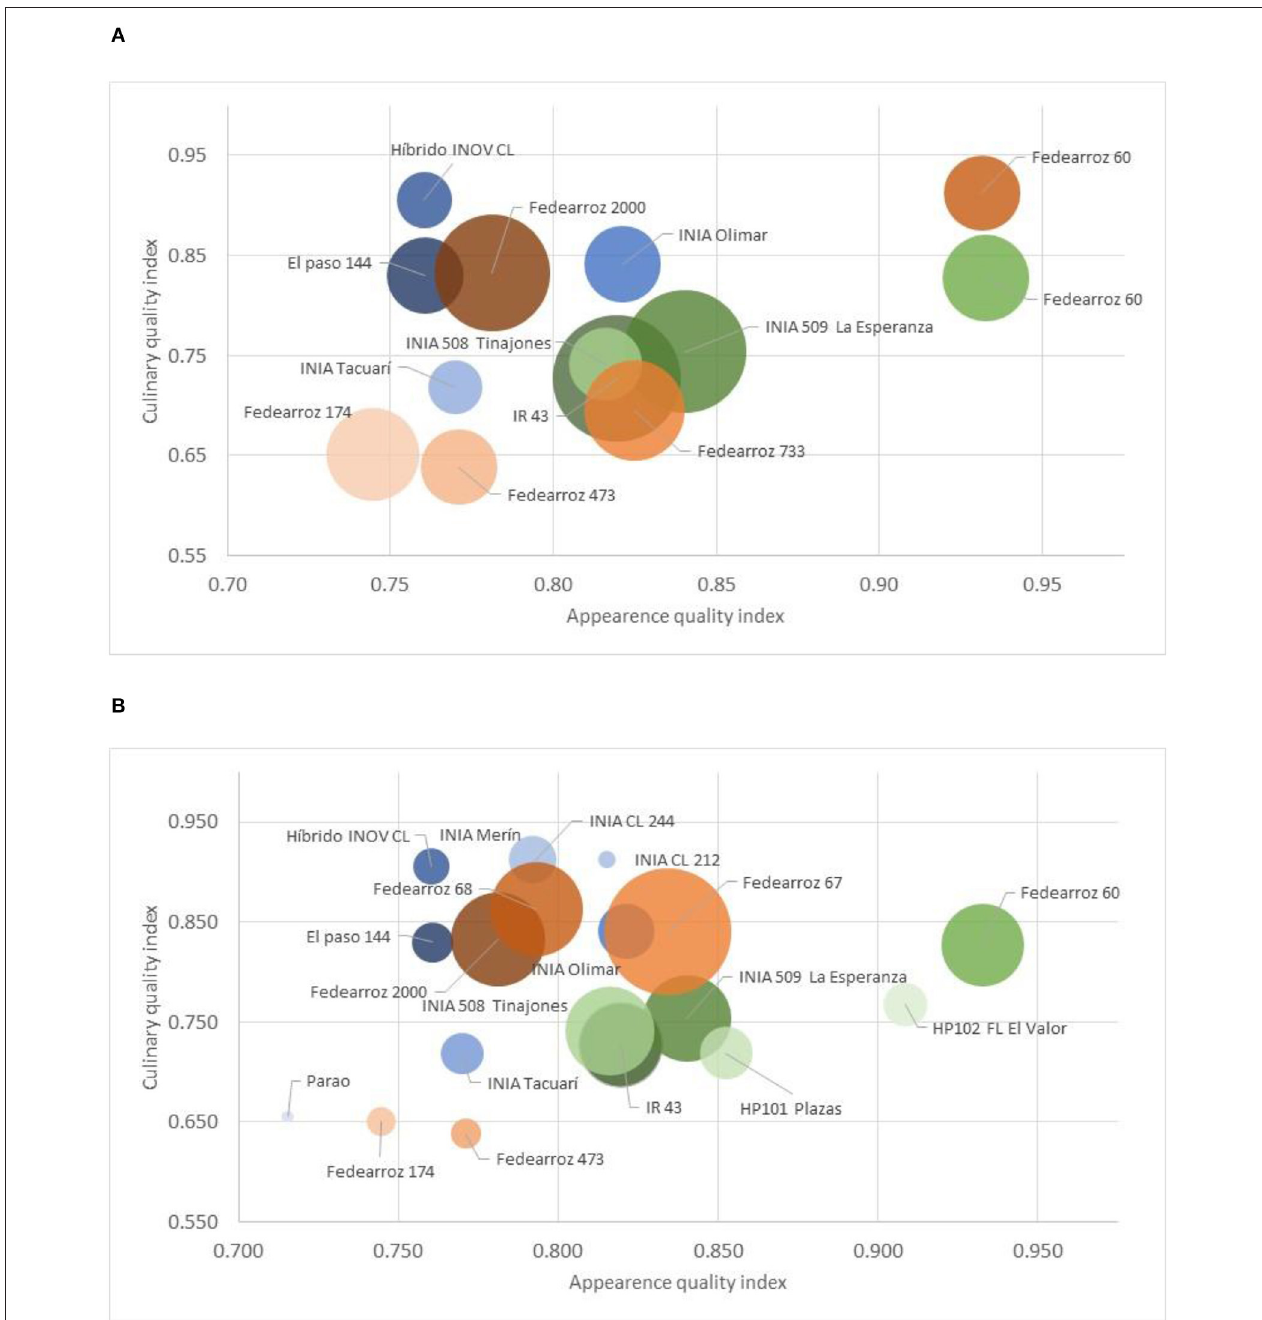
FIGURE 4 | Quality and adoption of improved varieties in Peru, Uruguay, and Colombia, 2014 and 2019. (A) Improved varieties adopted in 2014 and grain quality a . (B) Improved varieties adopted in 2019 and grain quality a . a Grain quality is calculated in two indices: (i) culinary quality and (ii) appearance quality. Culinary quality is the combination from amylose content and gelatinization temperature. Appearance index is the result of combining chalkiness index, length, and length-width relation. Bubble size represents hectares planted by each variety. Varieties used in Colombia are coded orange, those in Uruguay are coded blue, and those in Peru are coded